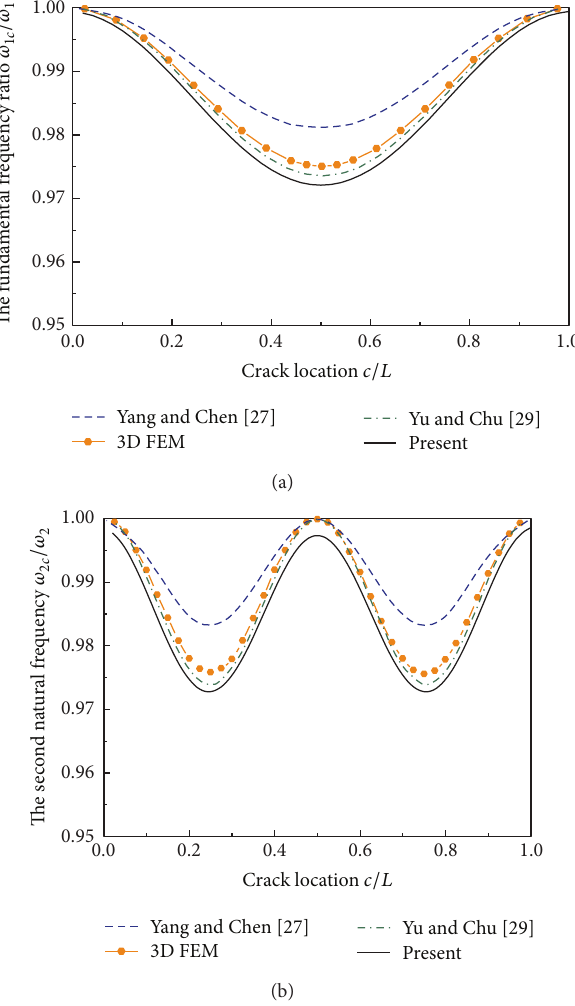
Figure 5: The first two frequency ratios of a hinged-hinged FGM beam with an open edge crack at varying locations: (a) the funda- mental frequency ratio and (b) the second frequency